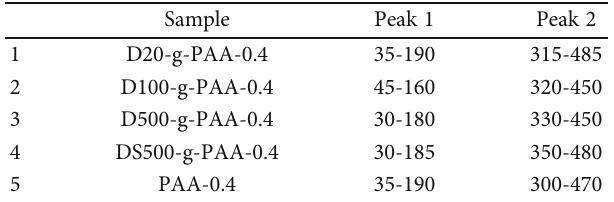
Table 3: Release of cefuroxime (in %) from the antibiotic-loaded hydrogels into water.